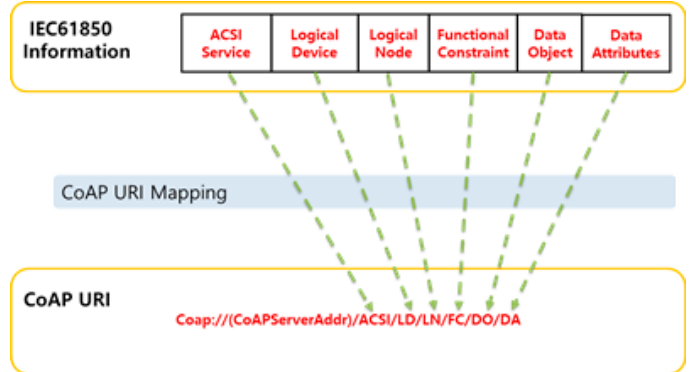
Figure 6. Map of the IEC 61850 data and CoAP URI.